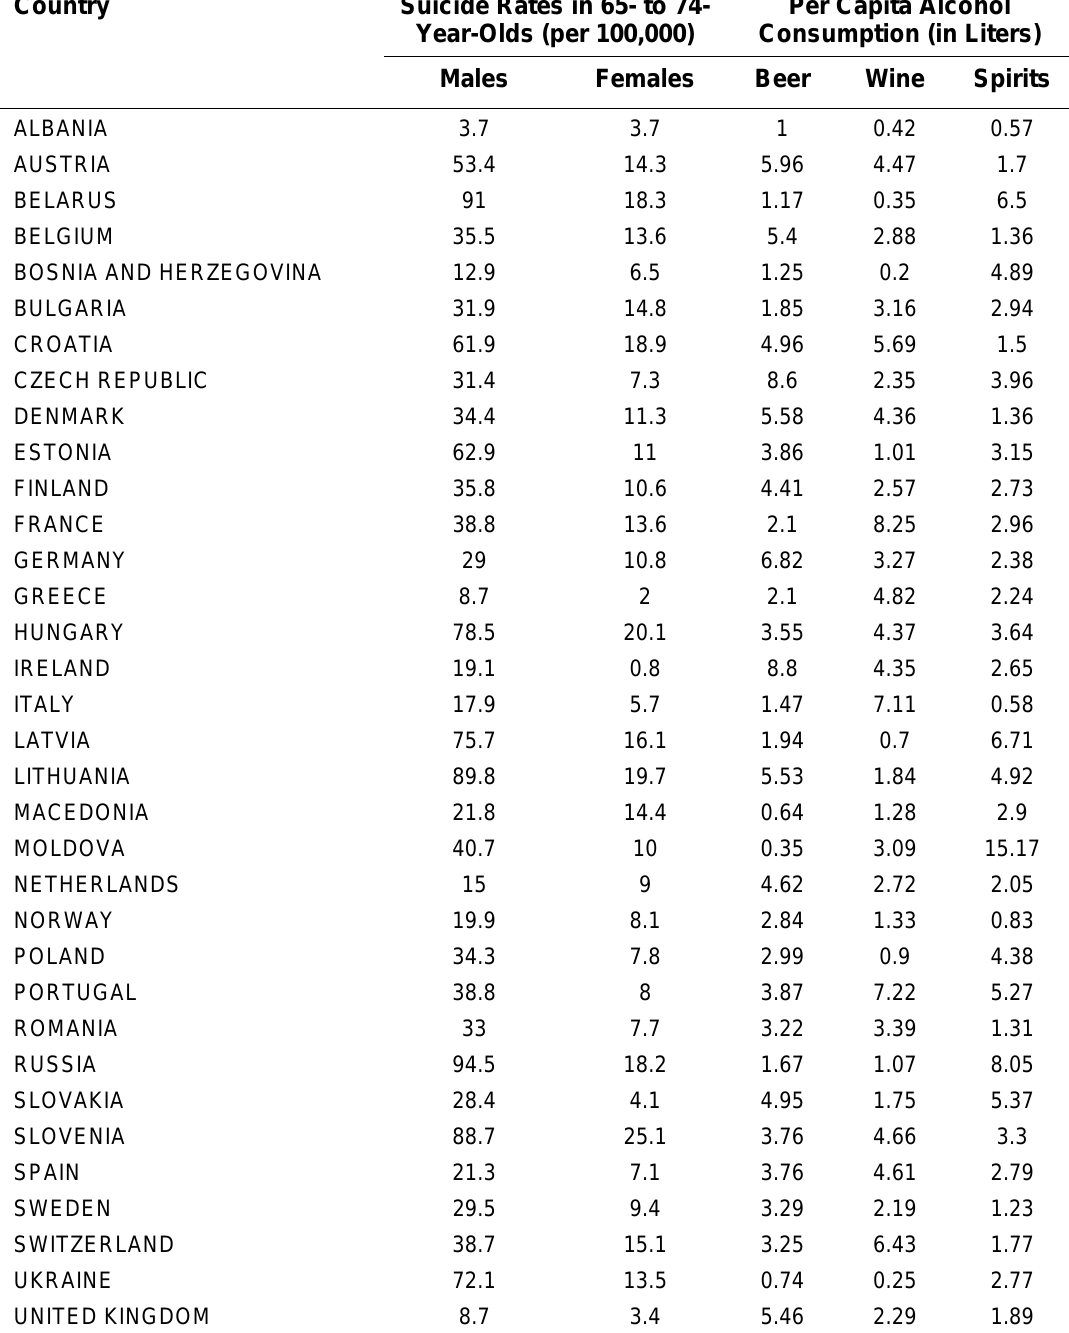
Suicide Rates in 65- to 74-Year-Olds and Per Capita Consumption of Alcoholic Beverages in the General Population in European